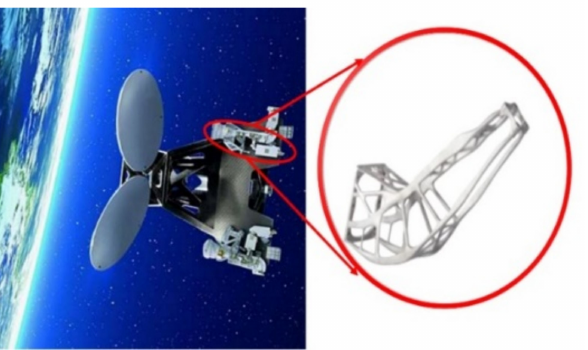
Figure 10. 3D printed Antenna bracket for reflector panel used on the Sentinel-1B satellite